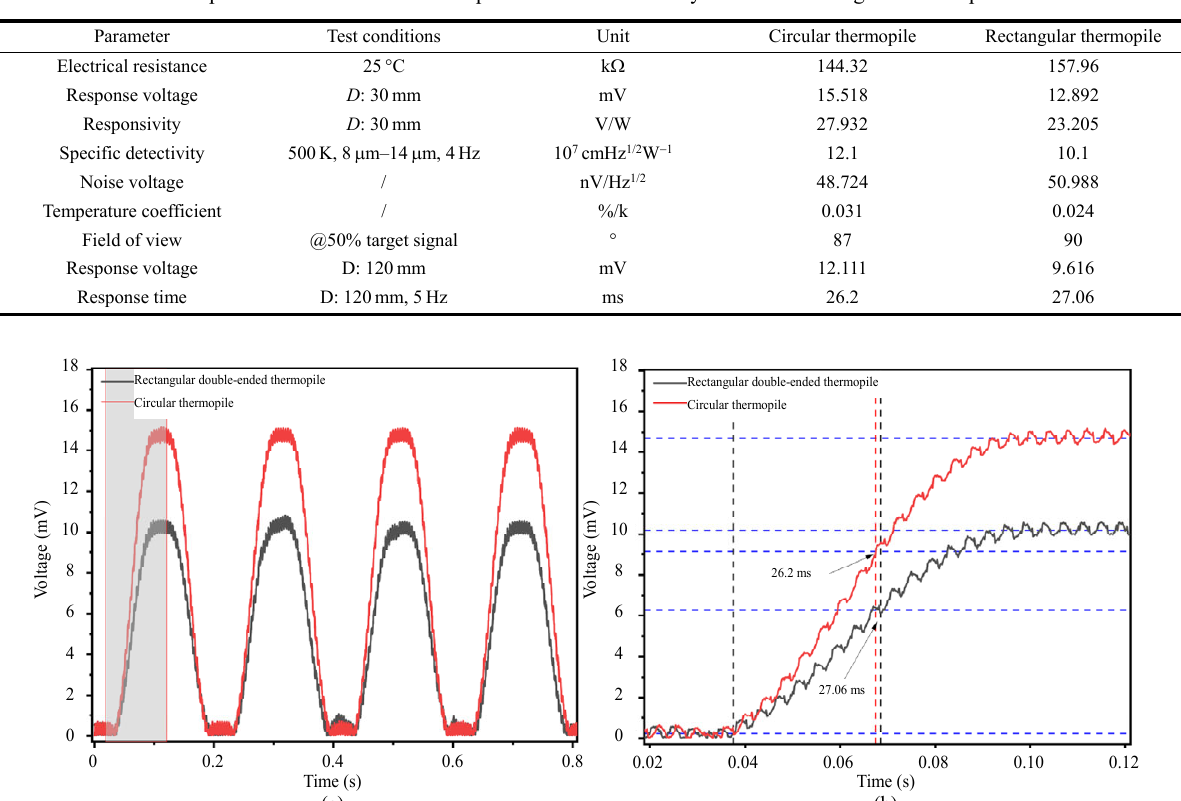
Fig. 11 Results of thermopile test with symmetrical and circular structures: (a) waveforms of thermopile infrared detectors for two structures and (b) rising edges of thermopile detectors for two